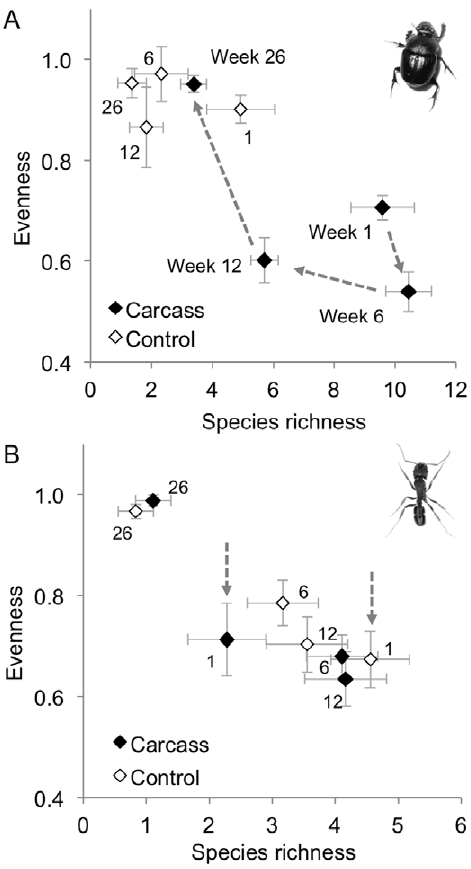
Figure 4. Effect of carrion on beetle and ant diversity. (a) Species richness and evenness of beetles at carcasses showed a trajectory through time clearly different from control sites at weeks 1, 6 and 12, with a return to similar levels at week 26 (blue arrows). (b) Species richness of ants at carcasses was half that at control sites during week 1 (red arrows), but was then similar to control sites at week 6, 12 and 26 of the experiment. Error bars show mean 6 SE.